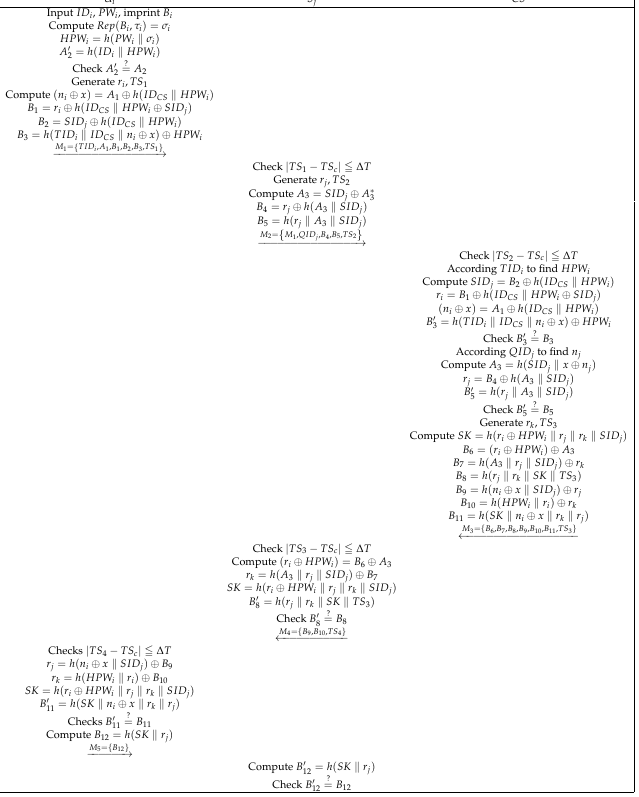
Figure 5. Login and authentication